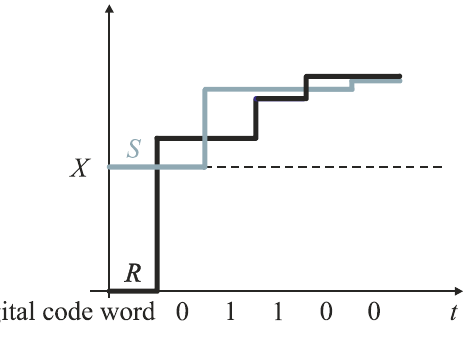
Figure 9. Monotone successive approximation.